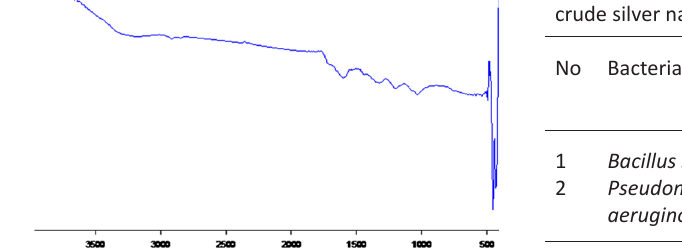
Table 2. Minimum Inhibitory Concentration (MIC)